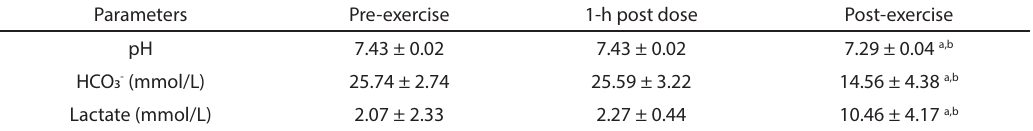
Table 4. Results of blood biochemical responses to NaHCO exercise in 13 well-trained sprinters. Data were analysed using paired sample t test Parameters